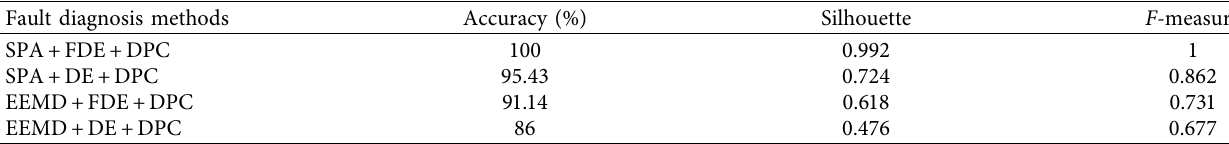
Figure 12: The clustering result of the rolling bearing by using the EEMD-DE-DPC: (a) decision graph and (b) clustering result. Table 4: The evaluation indexes of the rolling bearing under various fault diagnosis methods.